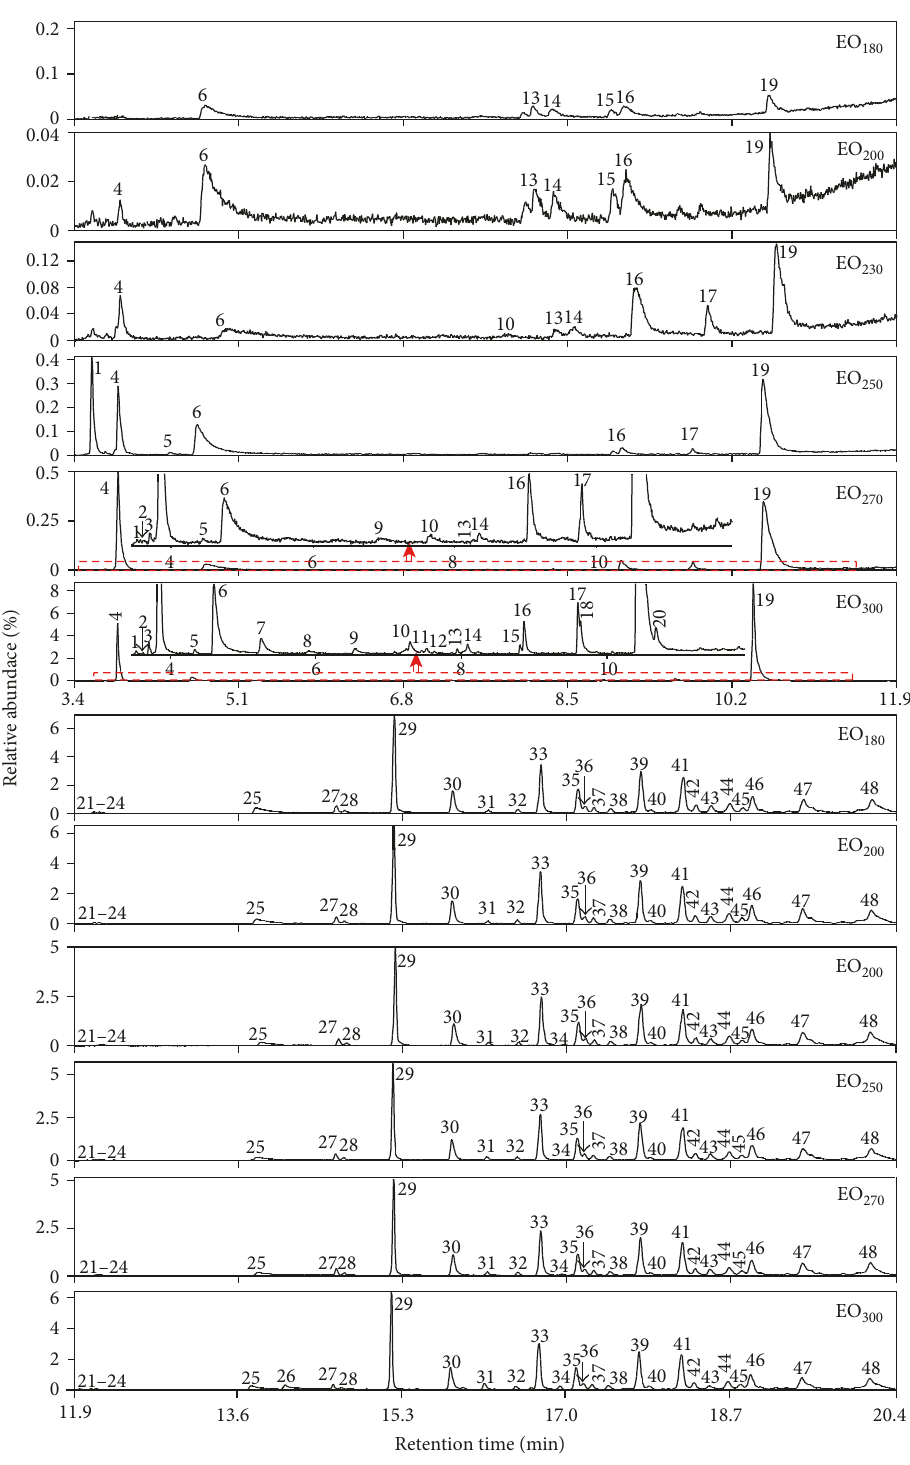
– EO before 20.4 180 300